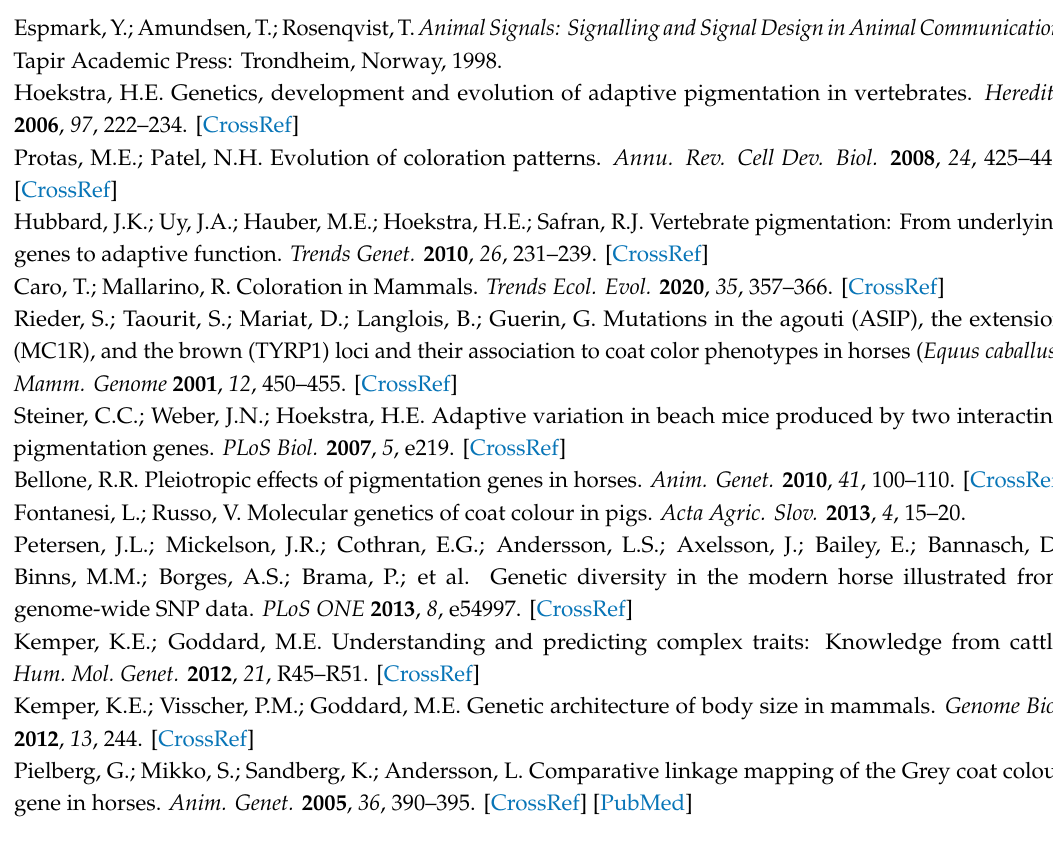
Table S1: Overall results of the F ST -outlier analysis performed contrasting each grey cattle breed with each of the four selected “non-grey” breeds. Table S2: Number of significant pair-wise contrasts detected for each SNP, within as well as across the four tested scenarios. File S1: Functions of genes in the ± 250 kbp region upstream and downstream of the locus Hapmap49624-BTA-47893 on BTA2, detected as significant in 100% of the pair-wise contrasts performed using Limousin as reference breed. File S2: Functions of genes in the ± 250 kbp region upstream and downstream of the locus Hapmap53144-ss46525999 on BTA4, detected as significant in 100% of the pair-wise contrasts performed using Holstein as reference breed. File S3: Functions of genes in the ± 250 kbp regions upstream and downstream of the nine SNP loci on BTA14, detected as significant in a number of pair-wise comparisons ranging between 15 and 36, and, in all instances, at least for 2 di ff erent reference breeds. File S4: Functions of genes in the ± 250 kbp region upstream and downstream of the locus ARS-BFGL-NGS-11271 on BTA26, detected as significant in 13 and 2 pair-wise contrasts performed using Holstein and Angus as reference breeds, respectively. File S5: Functions of genes located in the interval delimited by the SNPs BTB-01532239 and Hapmap27934-BTC-065223 on BTA14, in addition to the genes mentioned in Supplementary File S3. File S6: Gene enrichment analysis performed on the candidate genes detected as under di ff erential selection (Files S1–S5) by querying the Gene Ontology database. File S7: Gene regulatory network analysis performed using the candidate genes detected as under di ff erential selection (Files S1–S5) and querying the JASPAR TF binding site profile database. File S8: Non-exhaustive list of the online material screened in order to collect information on coat color phenotypes for the considered